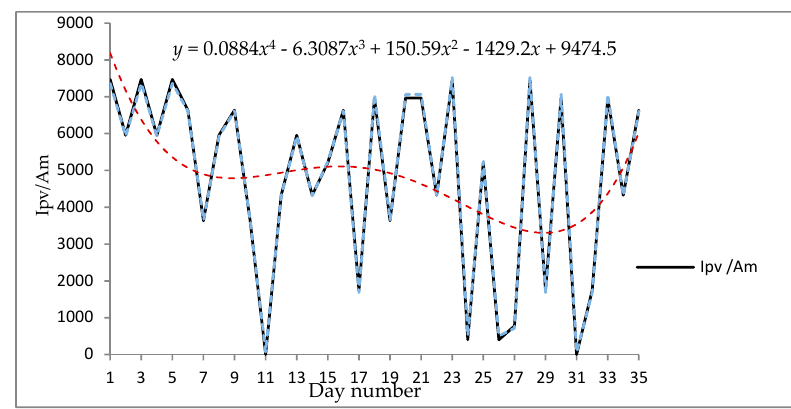
Figure 10. The testing results of the desired output and the forecasting SOFM output using 2000 epochs.